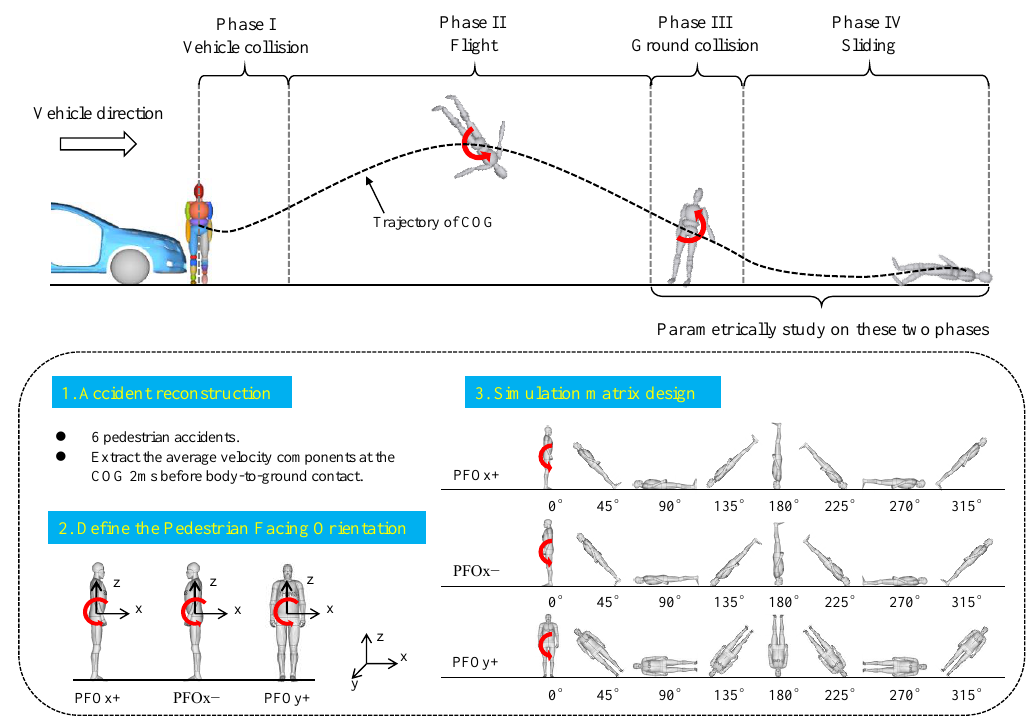
Figure 1. Methodology implemented for the parametric study.